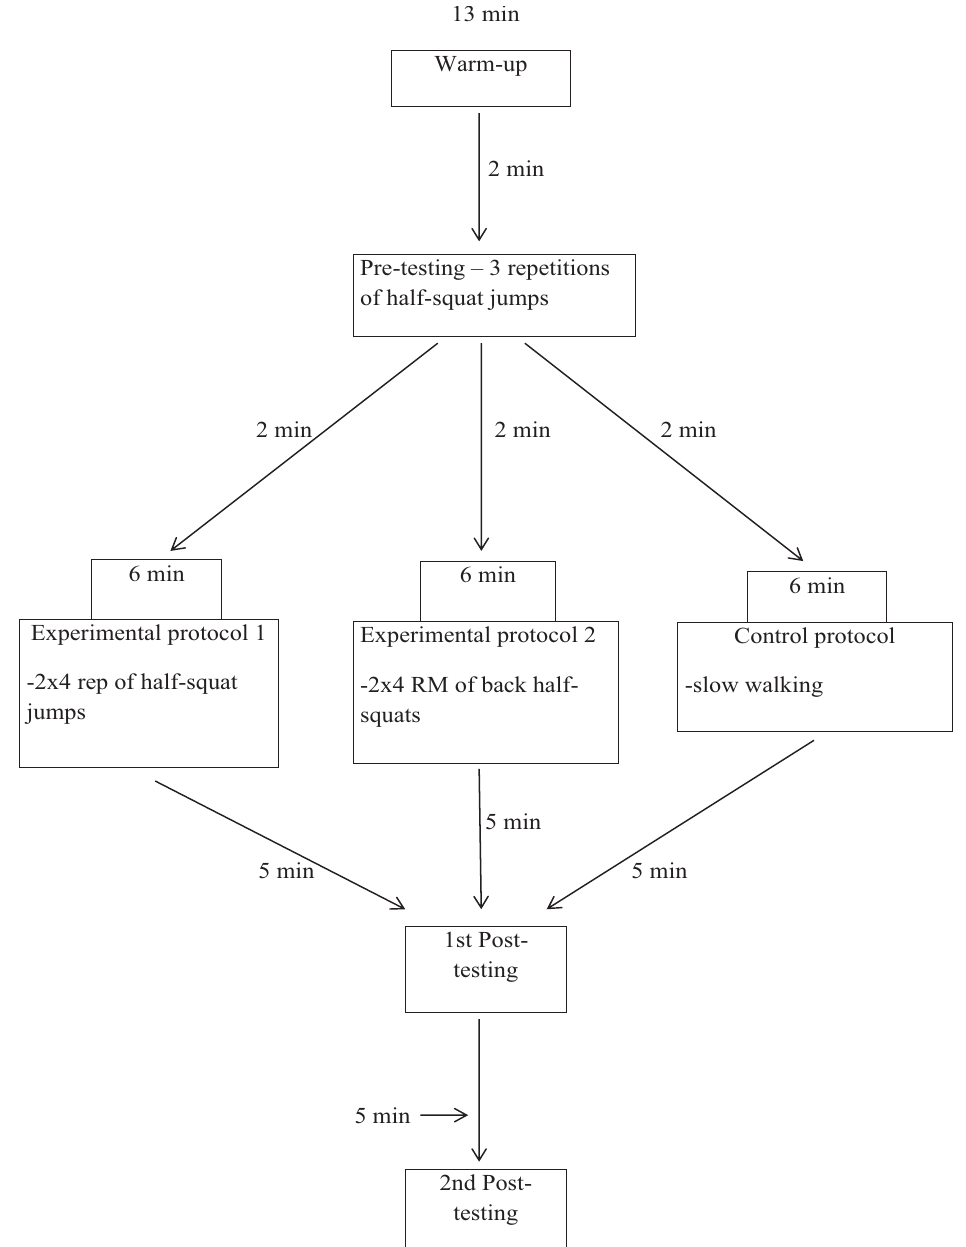
Figure 3. Schematic illustration of testing procedure during all conditioning protocols